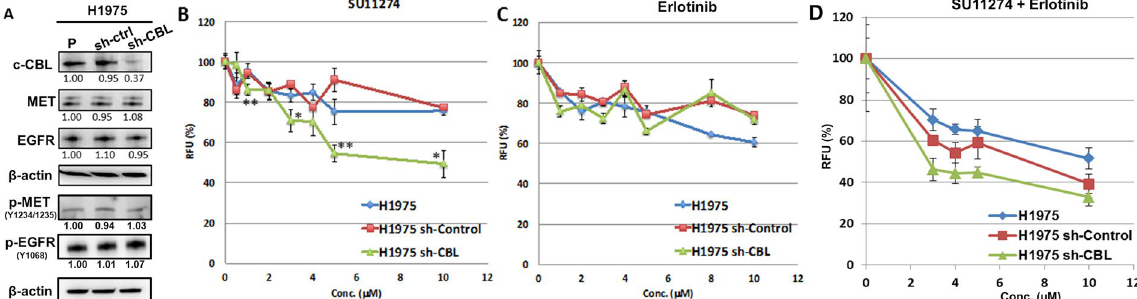
Figure 6. MET and EGFR inhibition in EGFR mutation cell line H1975. (A) CBL, MET, p-MET, EGFR, and p-EGFR protein expression in H1975 CBL knockdown cells. Protein expression was quantified and indicated with the fold change numbers shown below each immunoblot in comparison with parental H1975 cells. Each protein lysates of separated blot of were collected in the same time period for and the lysates were loaded in one gel per antibody staining. (p: parental, c: sh-control). (B) MET inhibitor SU11274, (C) EGFR inhibitor erlotinib, and (D) SU11274 and erlotinib combination were used to treat H1975, H1975 sh-control, and H1975 sh-CBL cells with variant dosages for 24 hr. * p < 0.05, ** p < 0.01. RFU: relative fluorescence